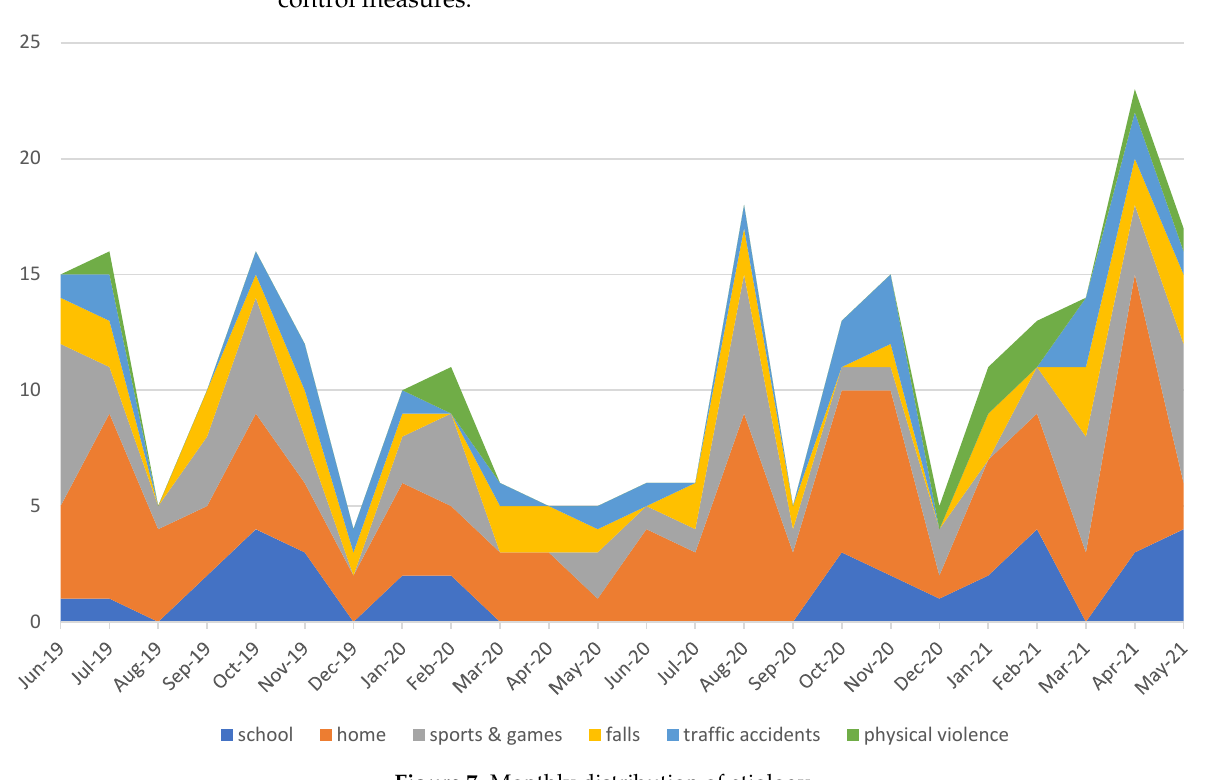
Figure 7. Monthly distribution of etiology